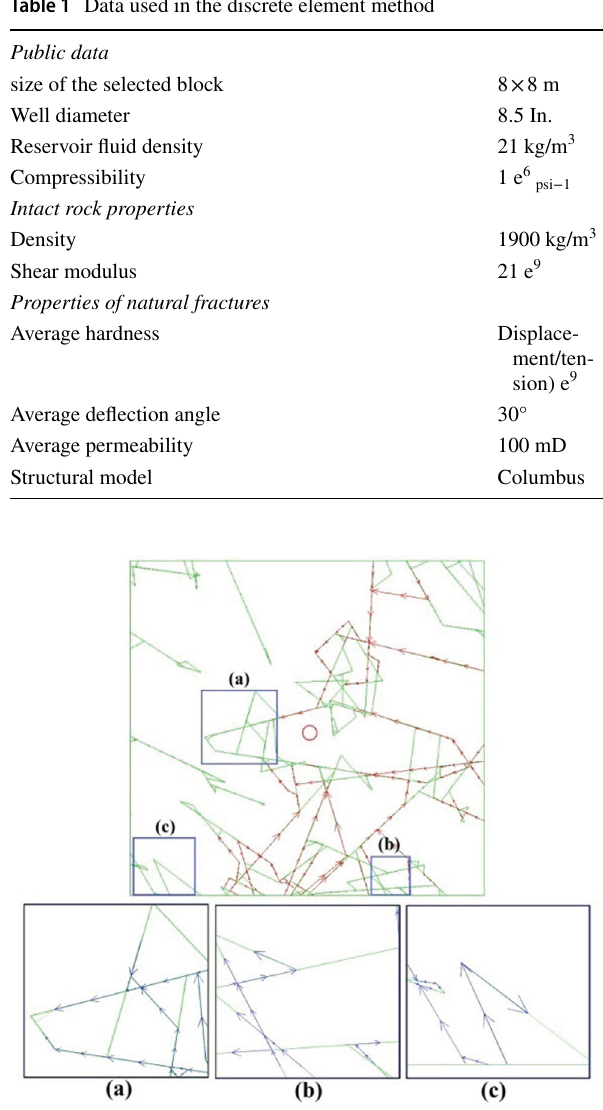
Fig. 10 Small currents in low-permeability